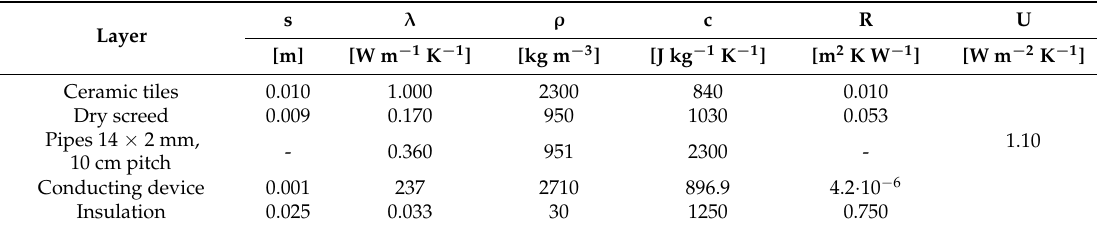
Table A6. Stratigraphy and thermal properties of the radiant floor with dry screed and aluminum diffusers (FD).